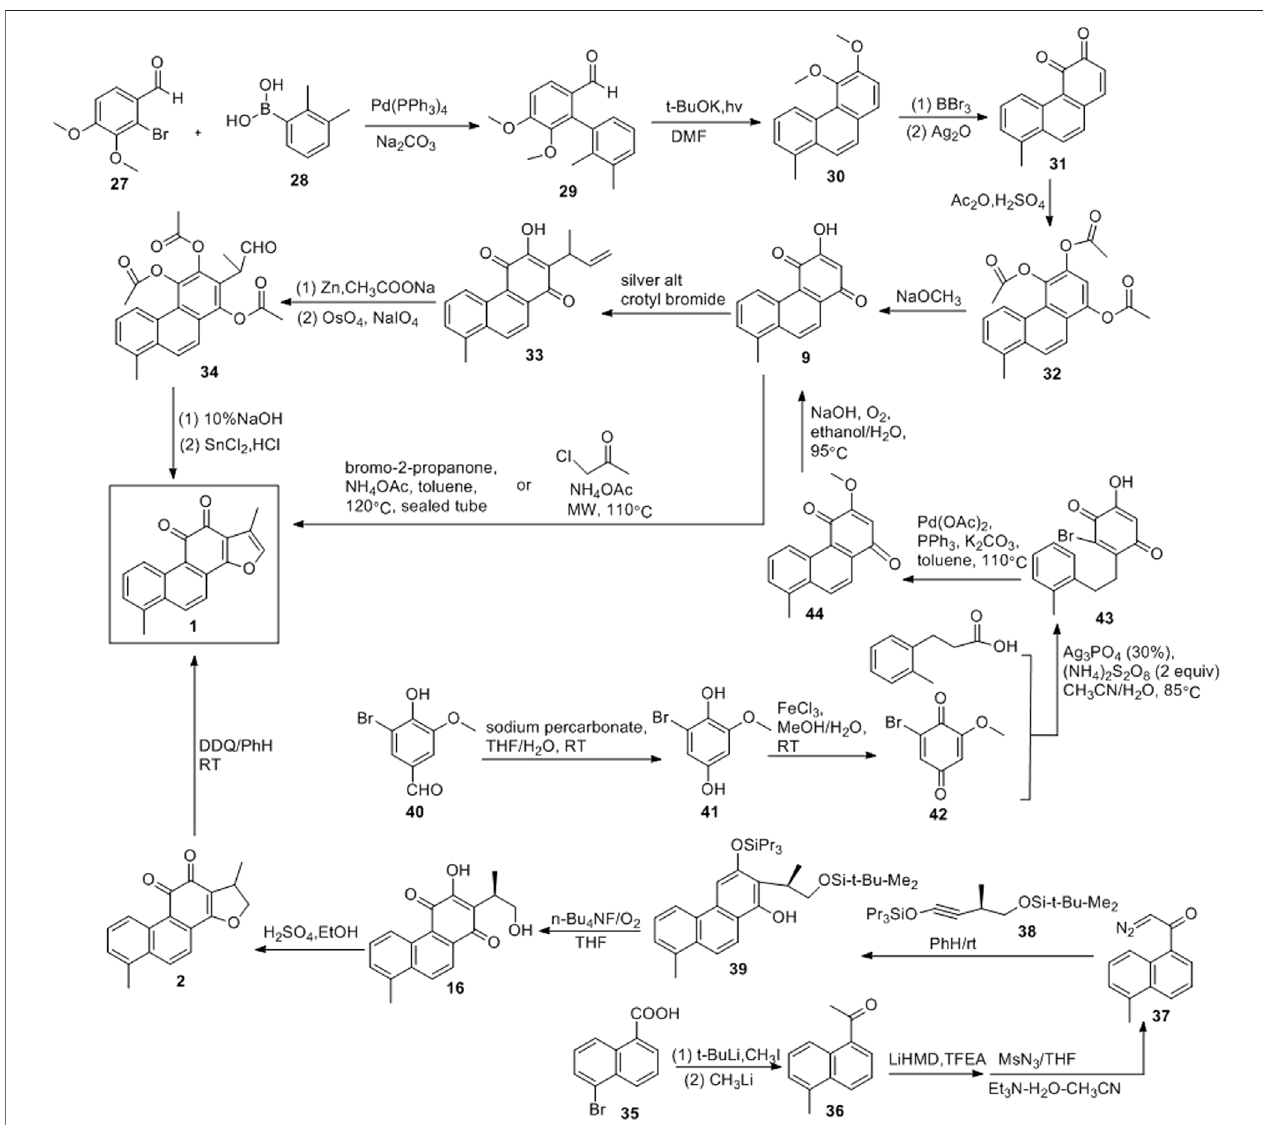
FIGURE 5 | Benzene or naphthalene derivatives addition